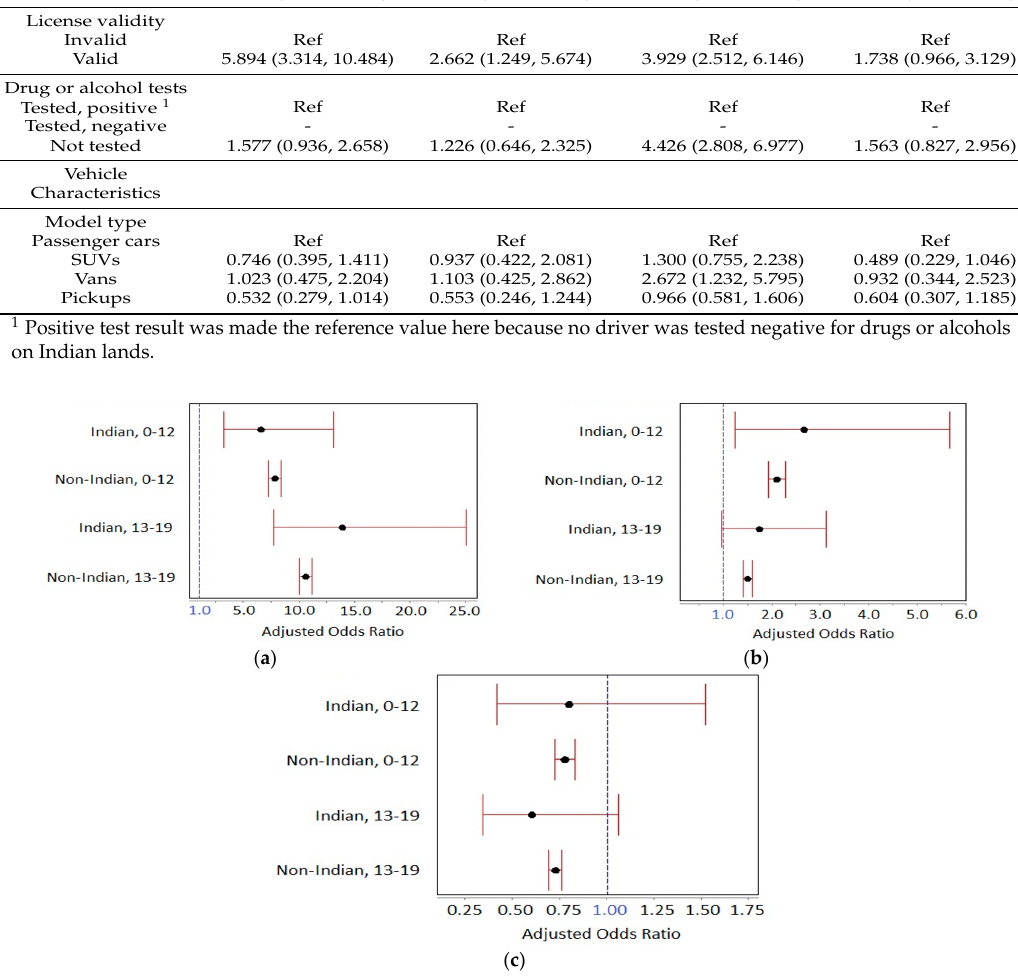
Figure 3. Independent predictors of passenger (aged 0–19 years) restraint use for Indian lands and non-Indian lands by age group, FARS 2000–2014: ( a ) Driver restraint use as an independent predictor of passenger (aged 0–19 years) restraint use (Adjusted for driver age, gender, license validity, drug/alcohol status and vehicle model type); ( b ) Driver valid license as an independent predictor of passenger (aged 0–19 years) restraint use (Adjusted for driver age, gender, restraint status, drug/alcohol status and vehicle model type); ( c ) Vehicle type as an independent predictor of passenger (aged 0–19 years) restraint use (Adjusted for driver age, gender, restraint status, license validity and drug/alcohol status ).